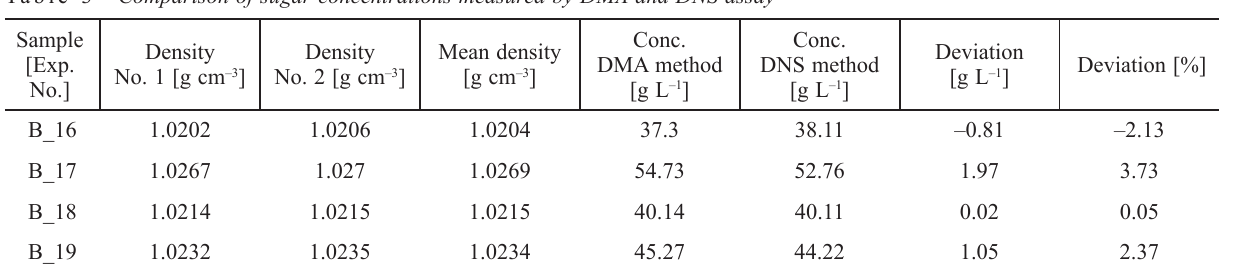
Table 3 – Comparison of sugar concentrations measured by DMA and DNS assay Sample [Exp.